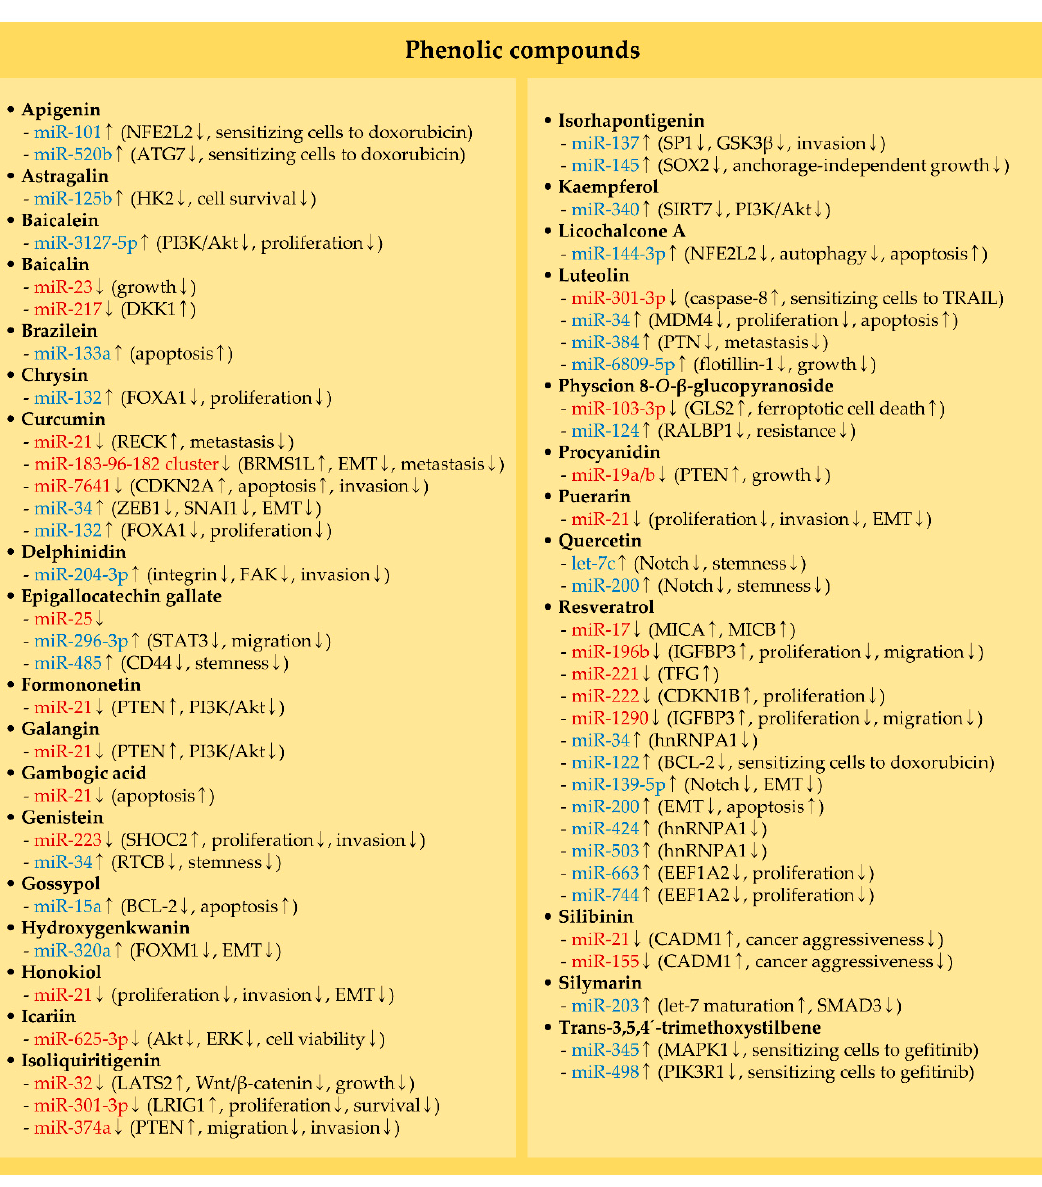
Figure 2. Effects of phenolic compounds on the expression level of oncogenic miRNAs (red) and tumor-suppressive miRNAs (blue). Arrows indicate the upregulation ( ↑ ) and downregulation ( ↓ ) of miRNA levels and consequential effects on cancer. The role of miRNAs in cancer therapy with phytochemicals is described in Sections 2 and 3.